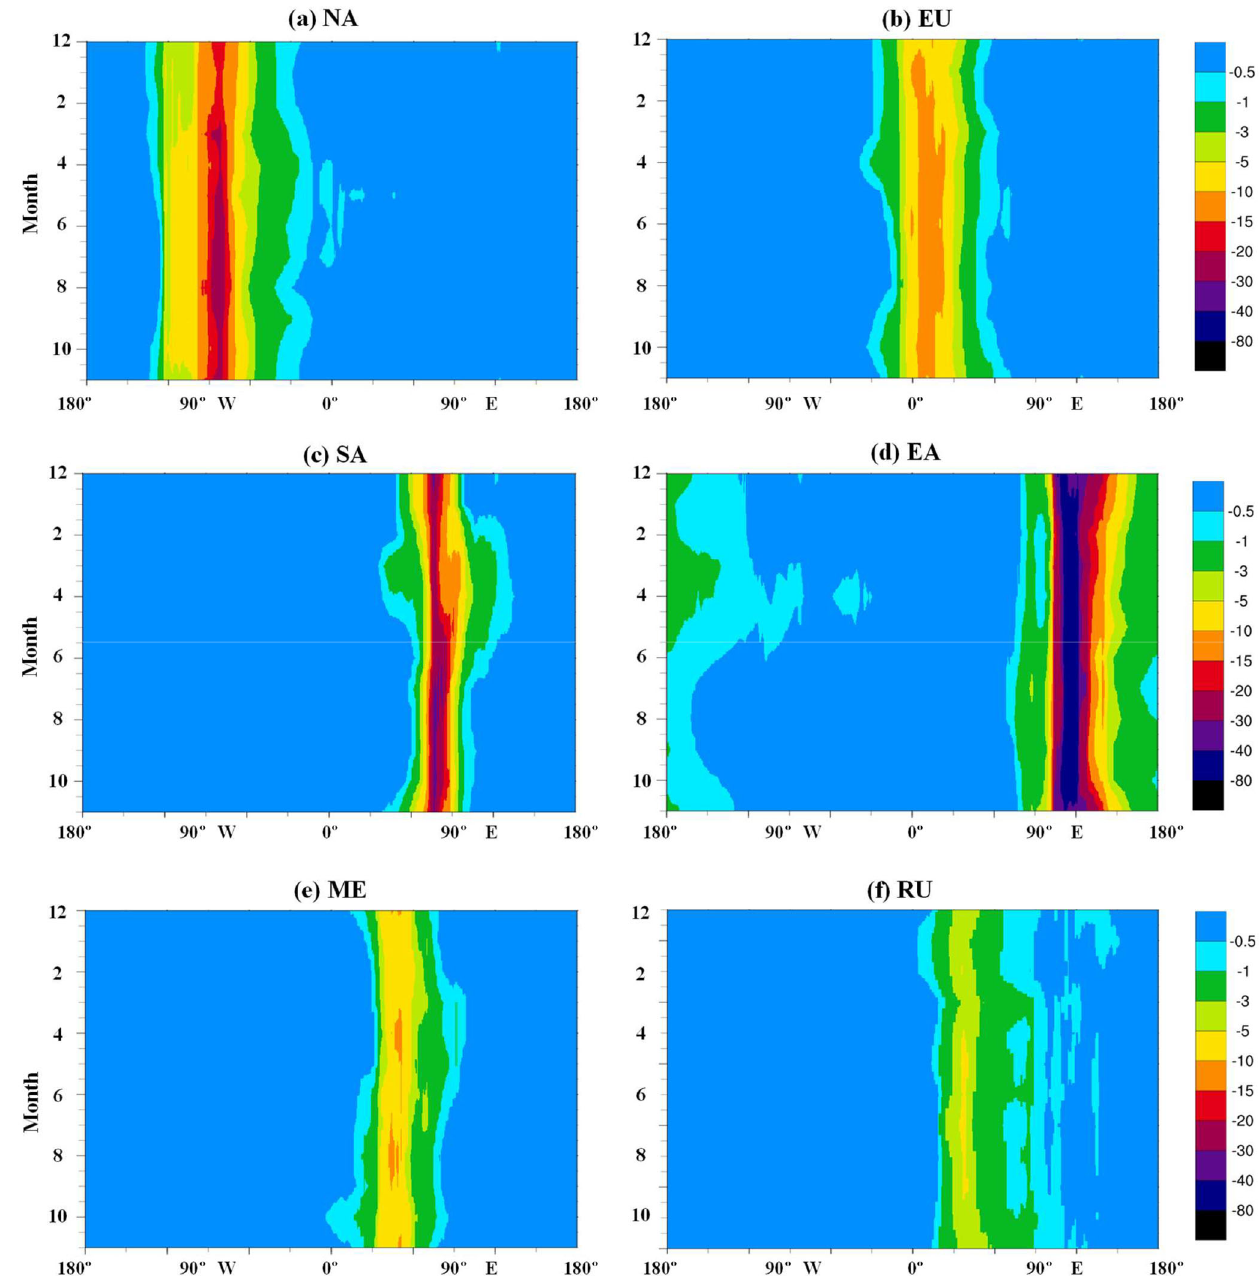
Figure 5. Same as Fig. 4 but for NO y deposition. The unit is × 10 4 kg(N)month − 1 per 0.1 ◦